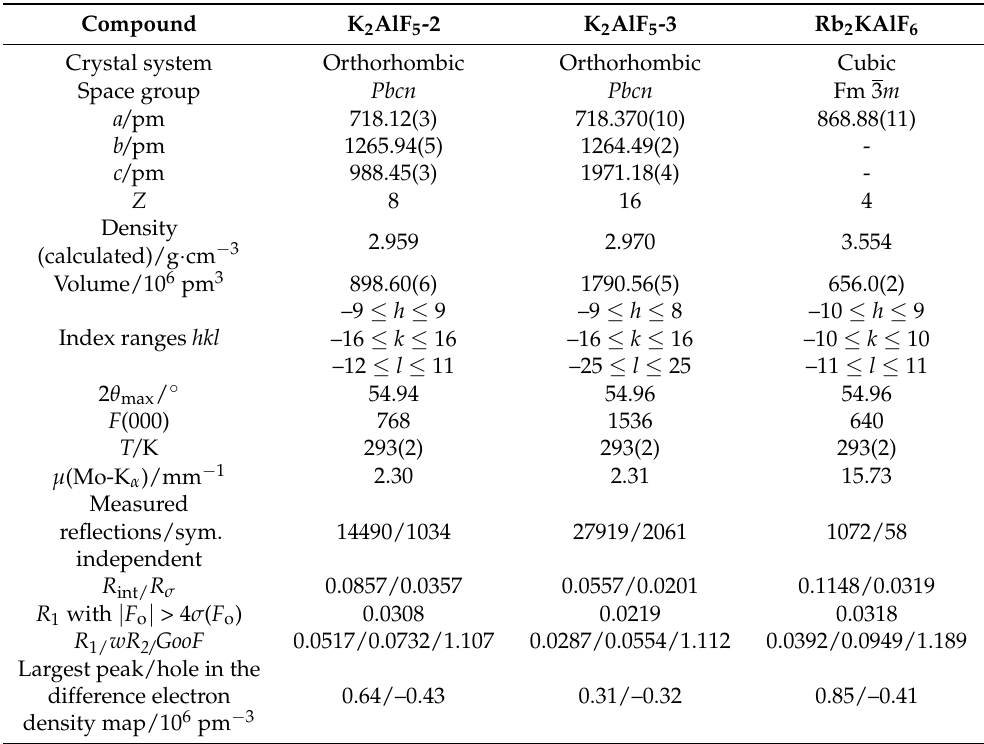
Table 1. Selected crystallographic parameters and refinement data of K 2 AlF 5 -2, K 2 AlF 5 -3, and Rb 2 KAlF 6 .